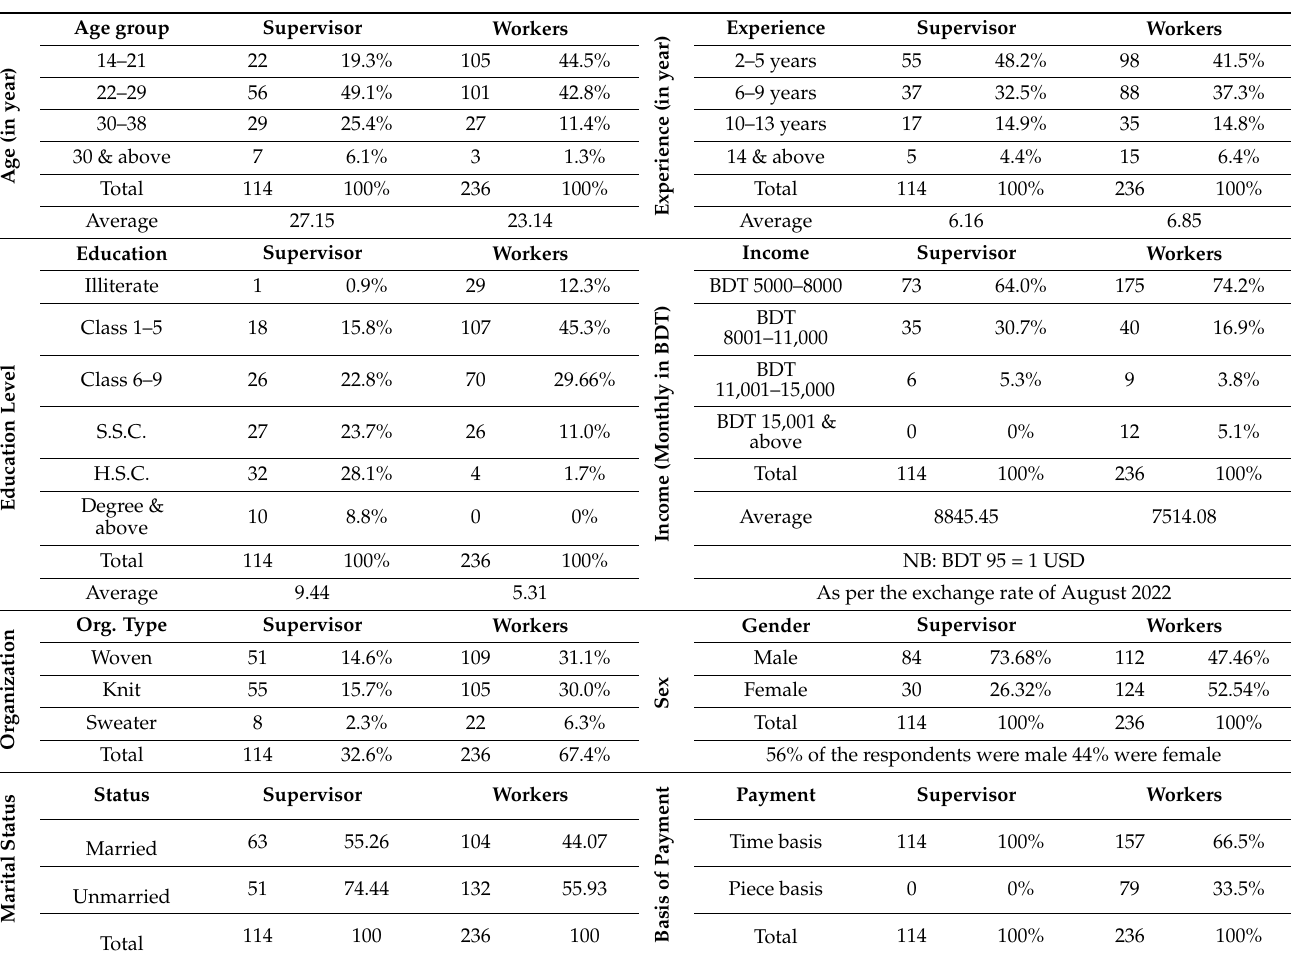
Table 2. Demographic Information of the